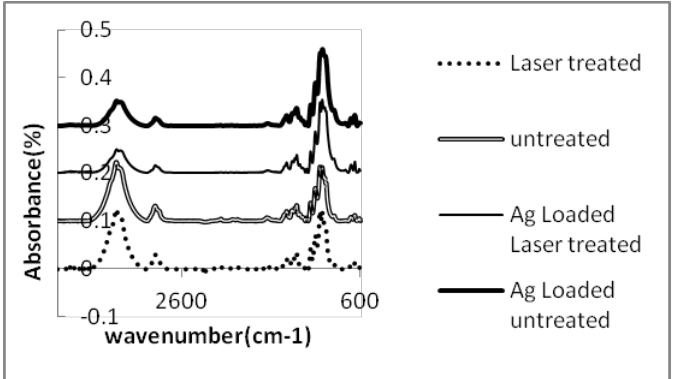
Figure 6. FTIR/ATR spectra of untreated, laser treated and silver nanoparticles coated